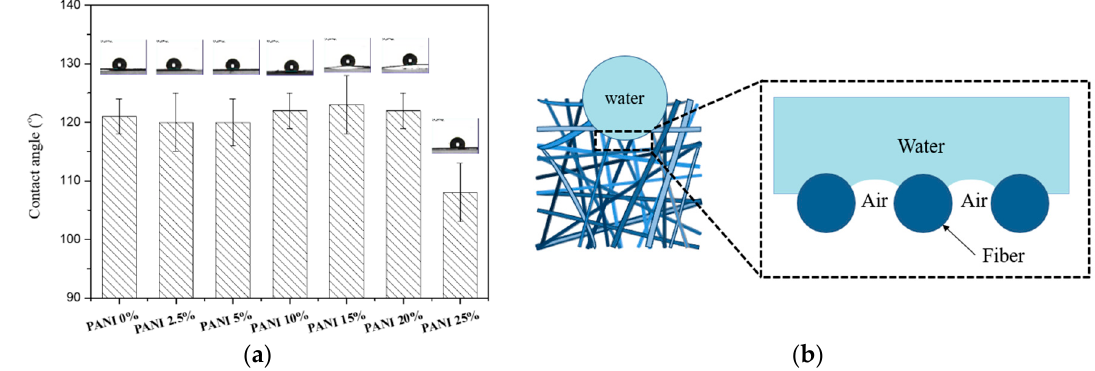
Figure 7. ( a ) Effect of adding PANI on the water contact angle of the electrospun PANI/ SF mats. ( b ) Illustration of silk fibroin/PANI composites’ morphology.